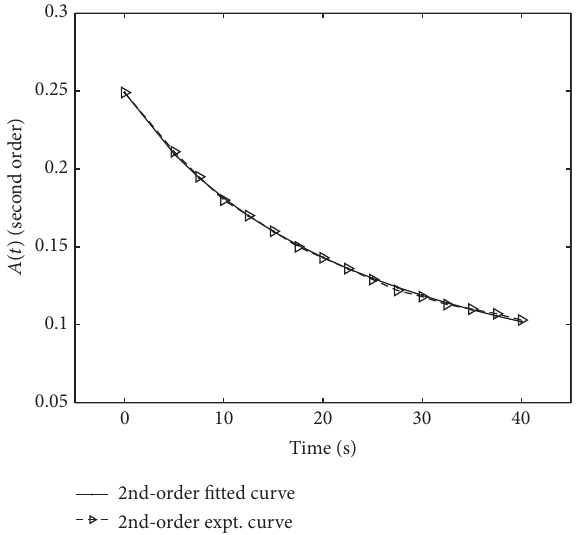
Figure 4: Graph of the experimental and calculated curve based on the current induced parameter-dependent optimization